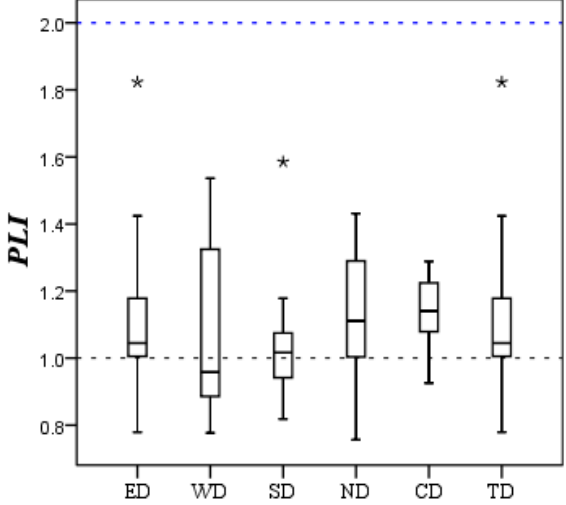
Figure 5. Box-plots of PLI for ESEs in smaller than 100 μm street dust particles from Xining (ED: East District; WD: West District; SD: South District; ND: North